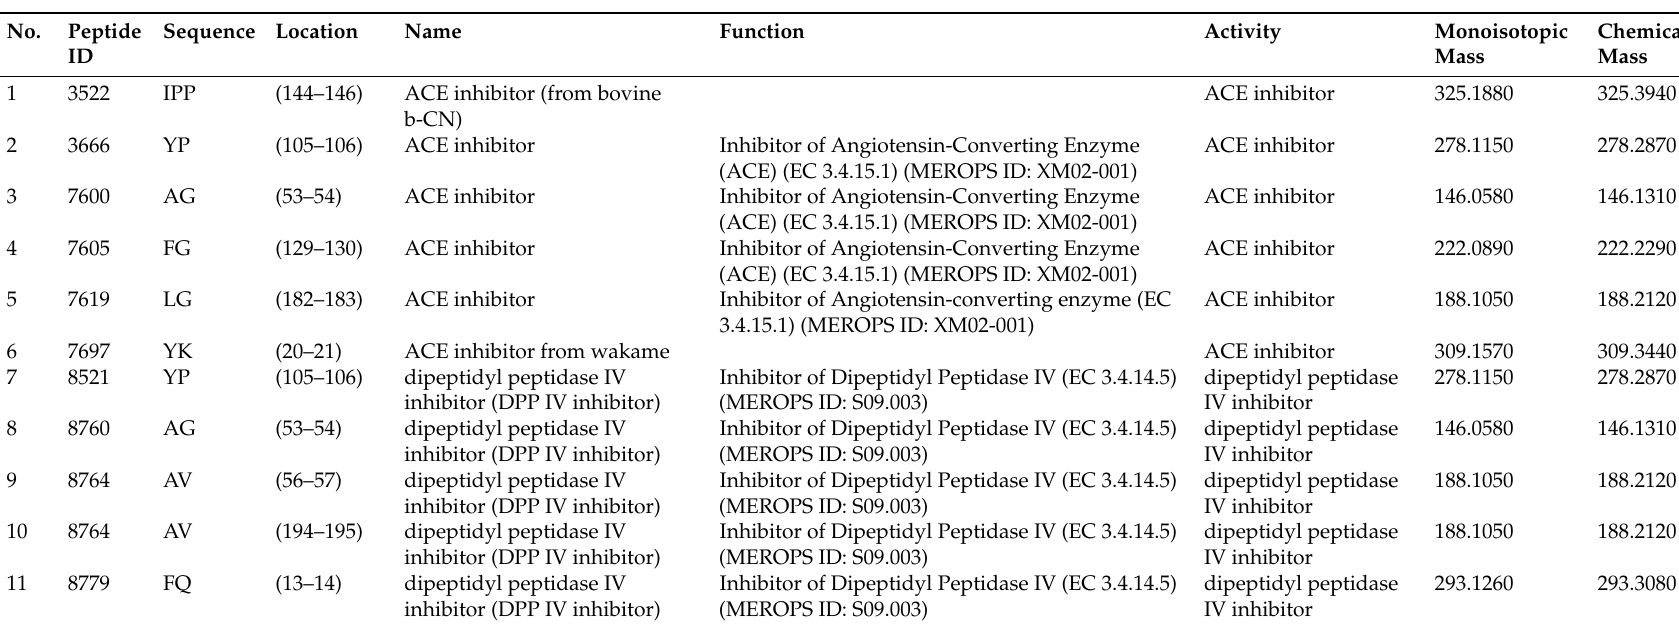
Table A51. Bioactive peptides from RubisCO of Halophila stipulacea . In silico enzymatic cleavage was carried out by using